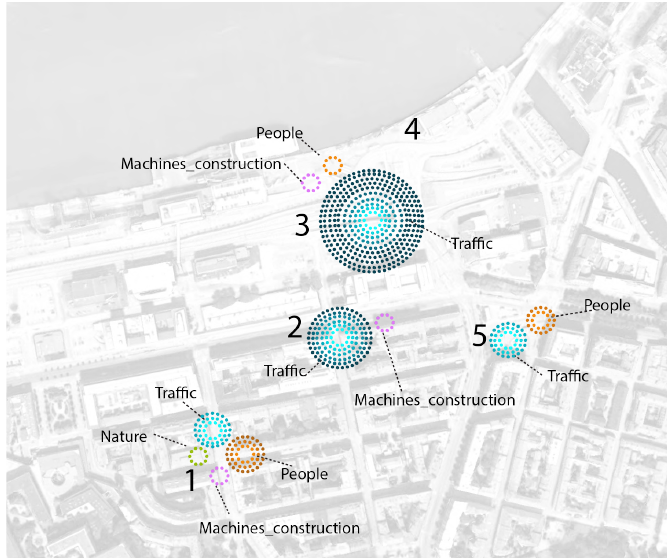
Figure 4. Site map: frequencies of sources heard. Each circle corresponds to 10% of the participants giving values of four (dominates) and five (dominates completely) on a scale 1–5 (Site 4 had no dominating sound source